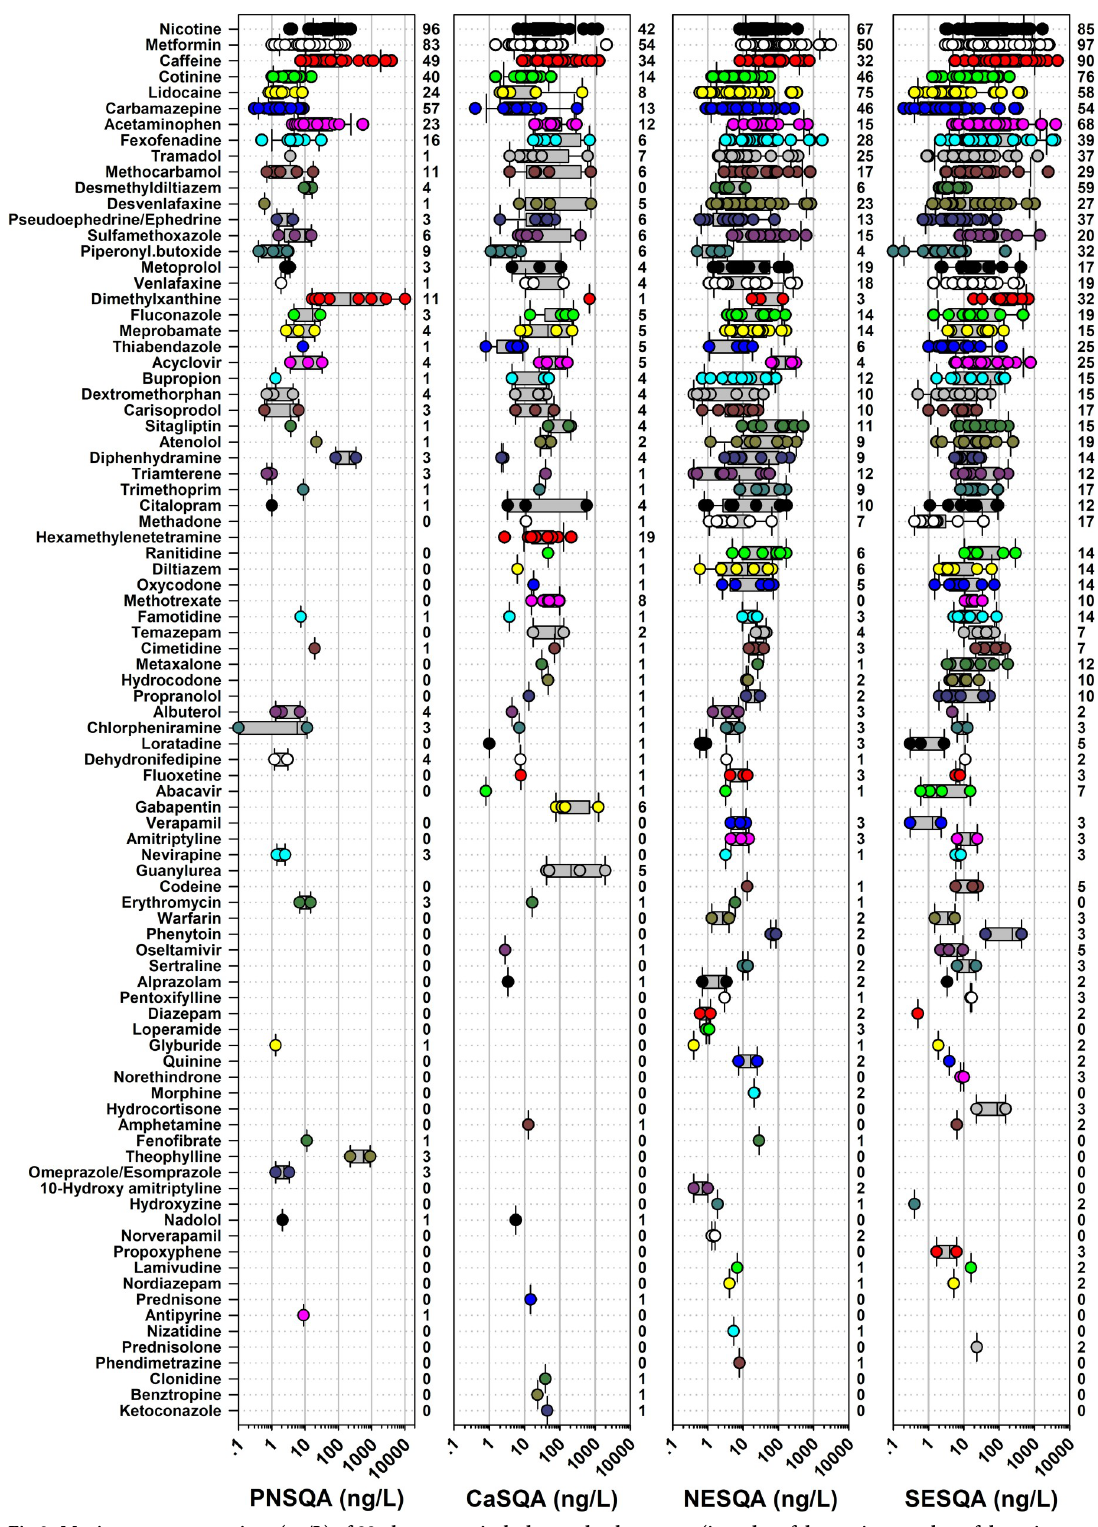
Fig 3. Maximum concentrations (ng/L) of 88 pharmaceuticals detected at least once (in order of decreasing number of detections across all regions and samples) in water samples from wadeable streams in each region as part of the USGS Regional Stream Quality Assessment (RSQA). Circles are data for individual sites. Boxes, centerlines, and whiskers indicate interquartile range, median, and 5 th